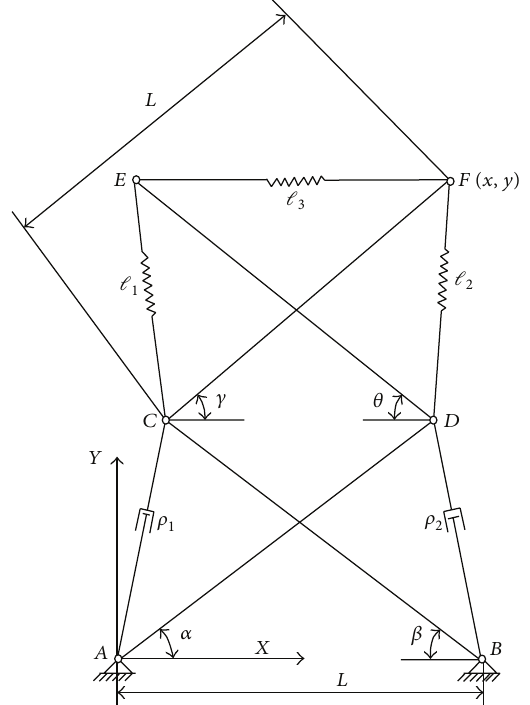
Figure 1: Planar 4-bar tensegrity